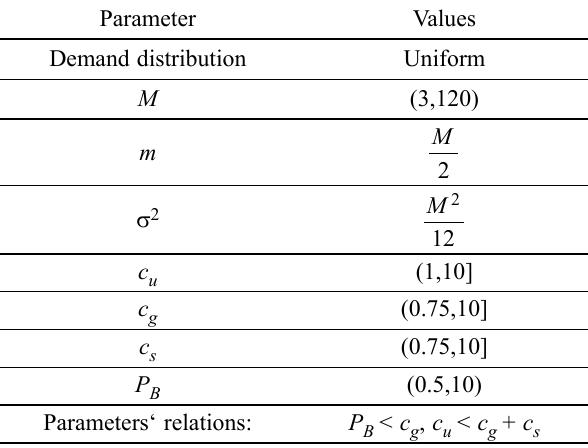
Table 1. Parameter values used in numerical